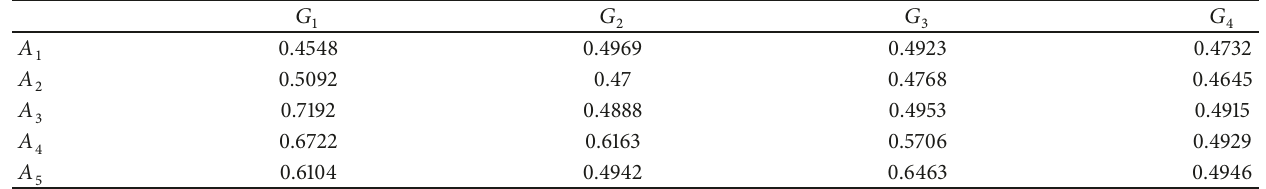
Table 10: Order-inducing vectors obtained by our TOPSIS-based method for problem in [39].